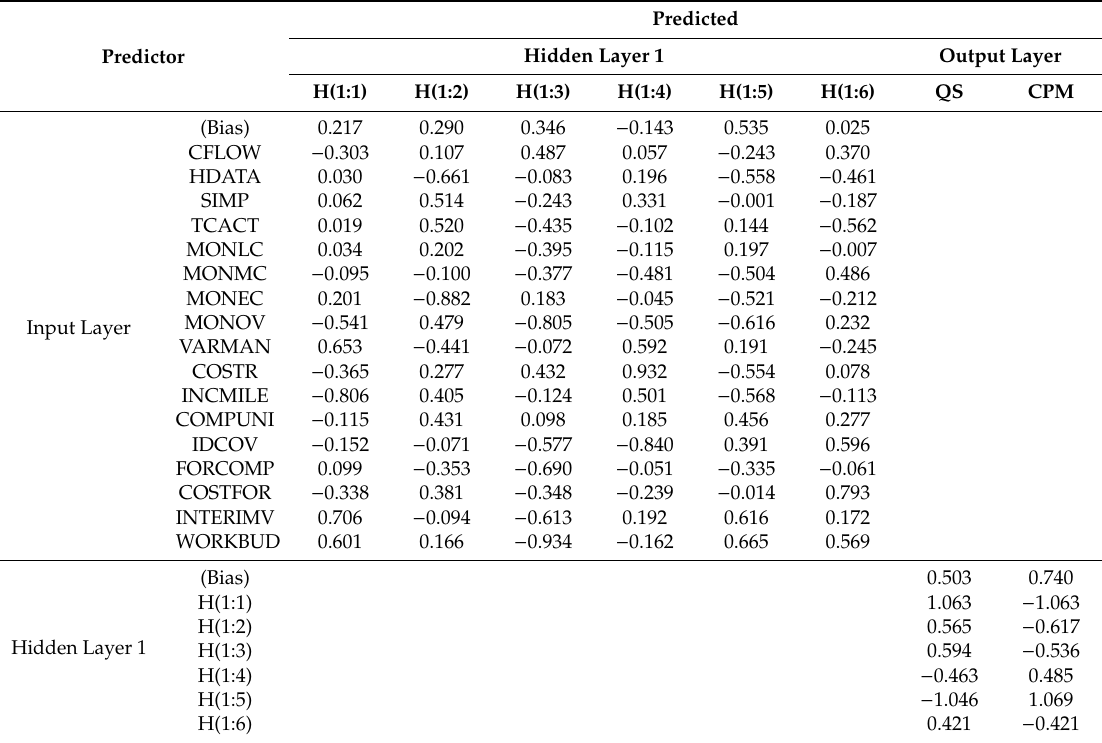
Table 3. Synaptic parameter estimates for level